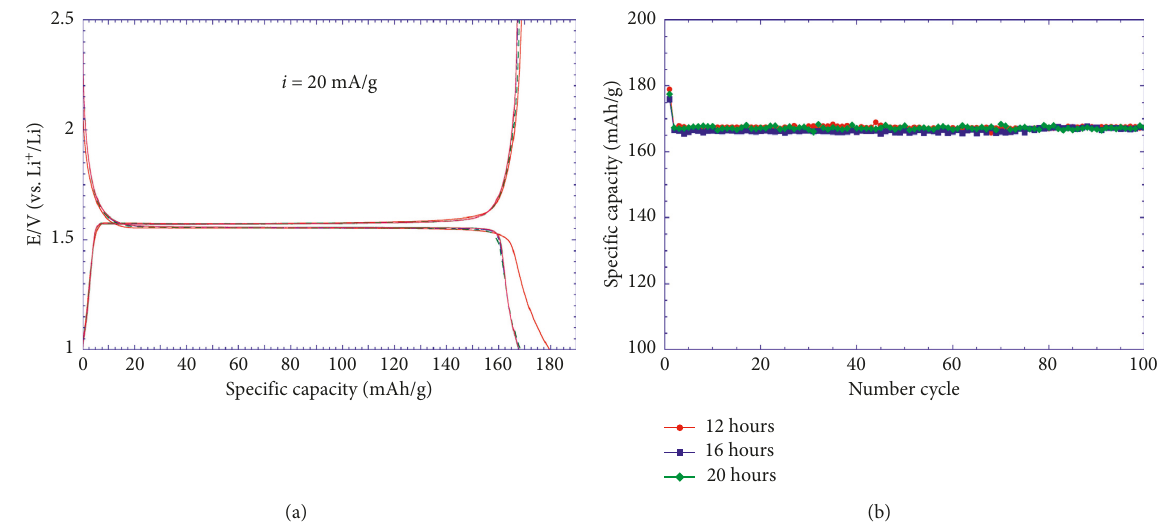
Figure 5: (a) Typical charge-discharge curves at current density of 20mA/g and (b) cycling performance of samples Li 700 ° C for 12hours, 16 hours, and 20 hours.